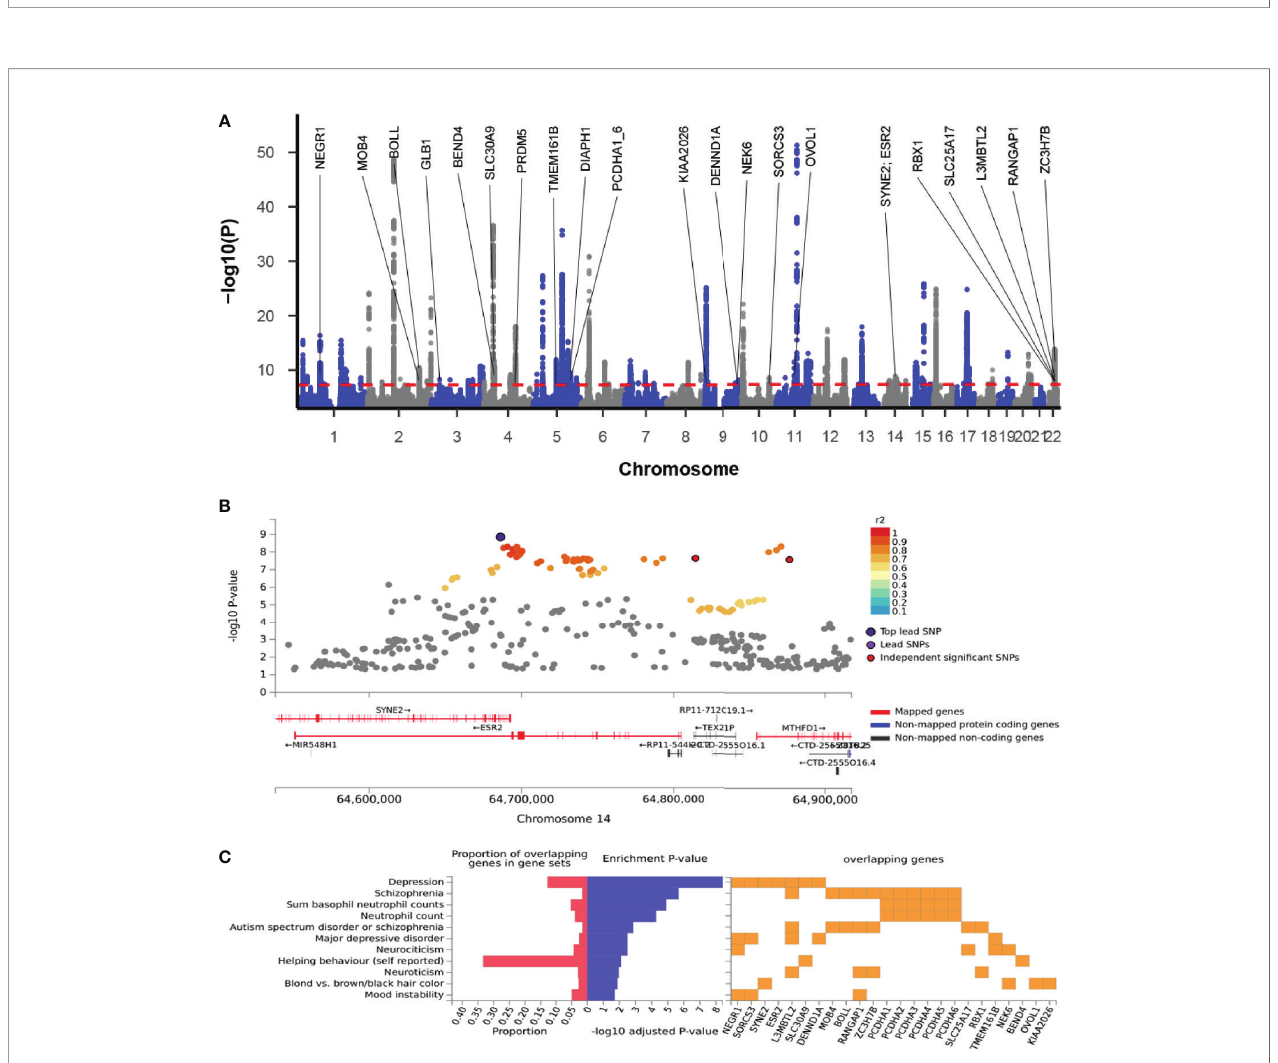
FIGURE 2 | Cross-trait meta-analysis of MDD and ADs. (A) Manhattan plot of meta-analysis of MDD with ADs. The x-axis is the chromosomal position of SNPs, and the y-axis is the signi fi cance of the SNPs (-log 10 P). Protein-coding genes containing or adjacent to independent signi fi cant SNPs shared by two traits were annotated. PCDHA1_6: PCDHA1 , PCDHA2 , PCDHA3 , PCDHA4 , PCDHA5 , and PCDHA6 . (B) The 14q23 locus containing the ESR2 gene. Each SNP is colored based on the highest r 2 to one of the independent signi fi cant SNPs. (C) Enrichment of the 27 protein-coding genes in GWAS catalog gene